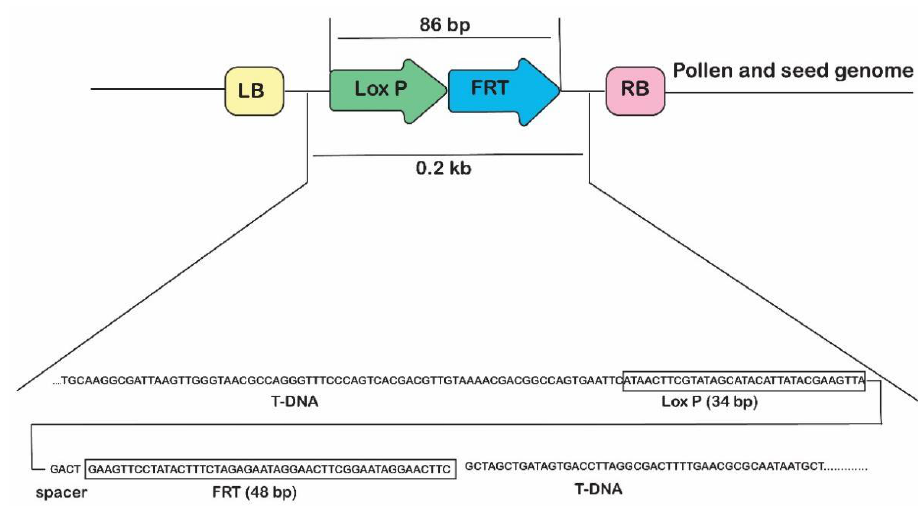
Figure 3. Confirmation of transgene excision in the ‘pollen- and seed-specific Gene Deletor’ system. Schematic representation of the excision of a portion of the transgenic genome. All DNA between the two fused LoxP-FRT sites, including the transgenes, is deleted specifically in the pollen and seeds, and the genomic DNA is then ligated by recombinase FLP, which is encoded by the FLP gene under the control of the pollen- and seed-specific promoter, PAB5. After the excision process, a short T-DNA residue (~0.2 kb) containing an intact fused LoxP-FRT site remains in the genome. LB and RB: left- and right-borders of the T-DNA, respectively; LF: fused loxP and FRT (loxP-FRT) recognition sequence; PAB5: pollen- and seed-specific Arabidopsis PAB5 gene promoter; P35S: CaMV 35S gene promoter; Tnos: terminator of the Agrobacterium tumefaciens nopaline synthase gene; FLP: FLP recombinase gene; NPTII: neomycin phosphotransferase II gene (kanamycin resistance was used as the plant selection